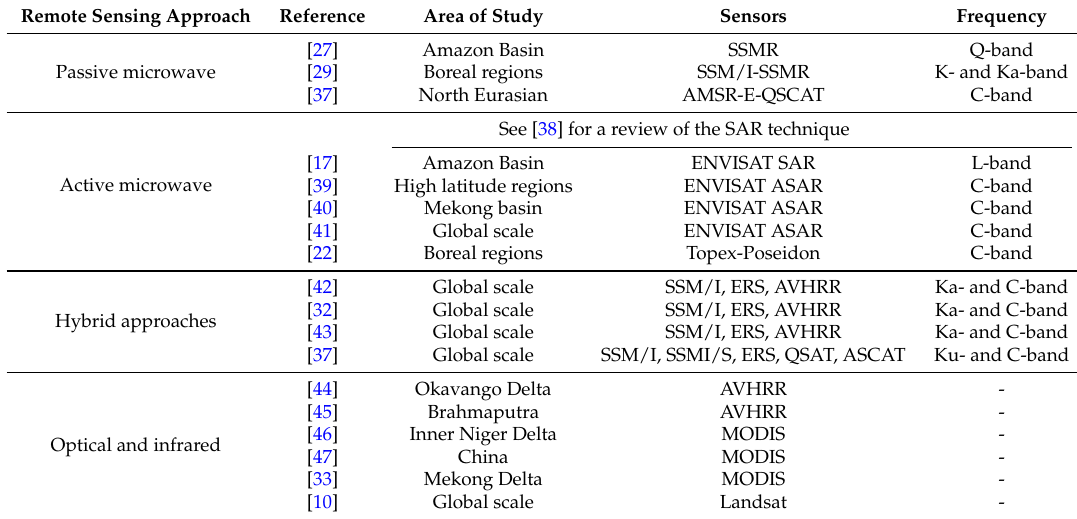
Table 1. List of selected scientific papers on the observation of the water surface over the continents from space. References, area of study and sensors are